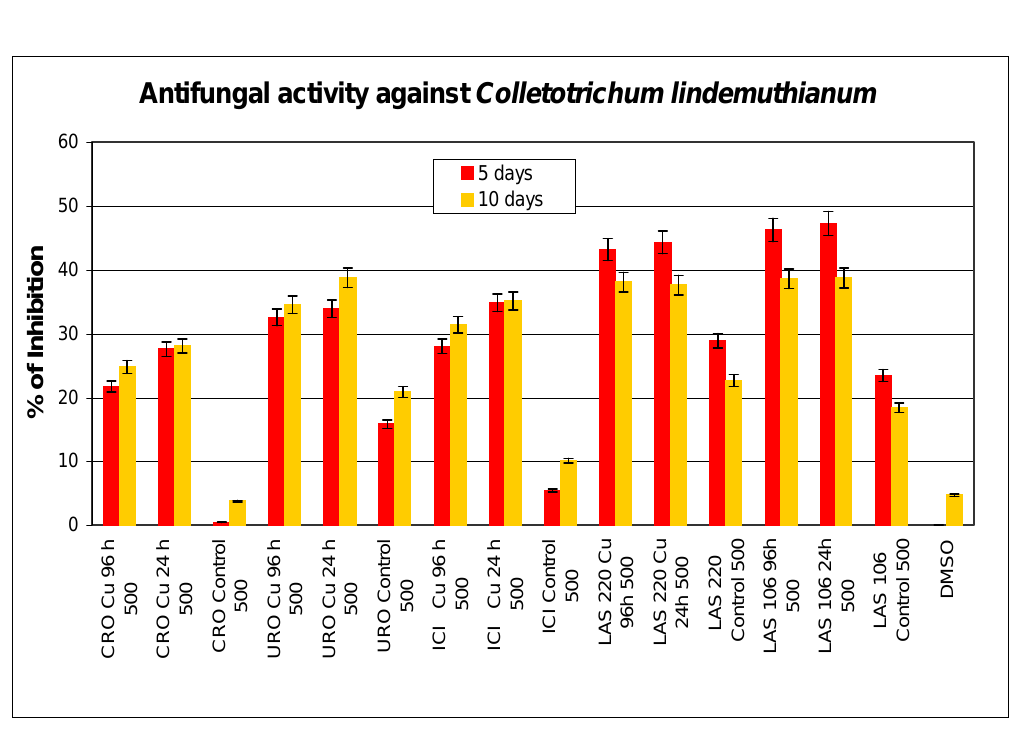
treated-susceptible/resistant bean extracts against Figure 8 . Antifungal activity of CuCl 2 Colletotrichum lindemuthianum